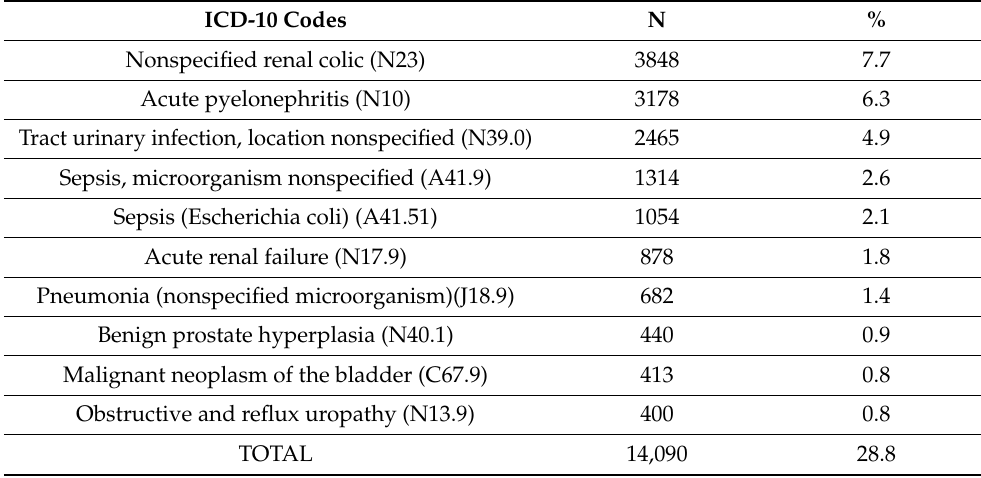
Table 4. Most frequent causes of hospitalization when a kidney or ureteral stone was not coded as the main